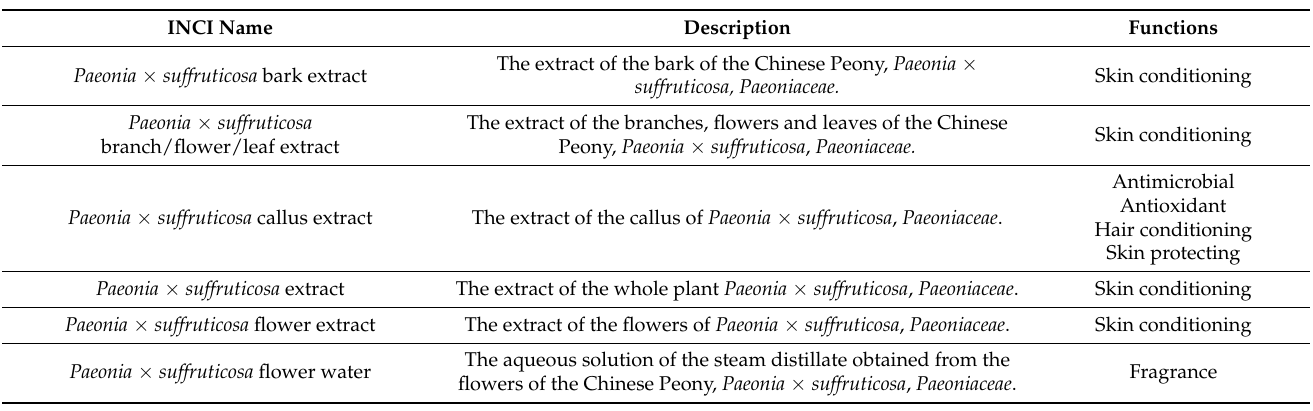
Table 4. Possible applications of Paeonia × suffruticosa in cosmetology as recommended by the CosIng